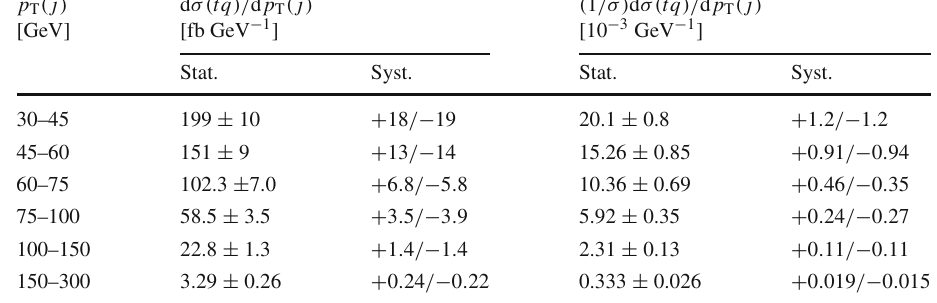
normalised unfolded differential tq production cross-section as a function of p T ( ˆ j ) at particle